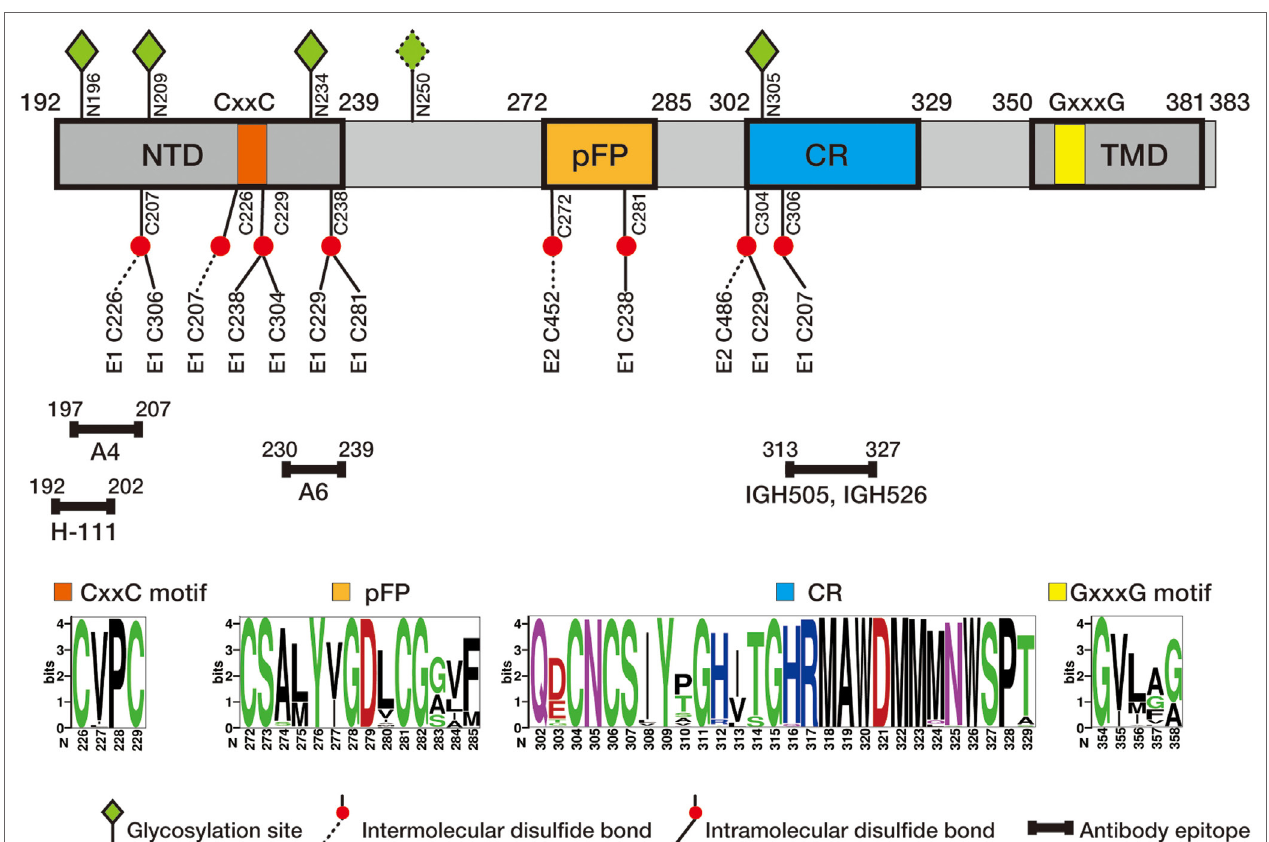
FiGURe 1 | Schematic diagram of hepatitis C virus (HCV) E1 envelope protein. E1 contains N-terminal domain (NTD, 192–239), putative fusion peptide (pFP, 272–285), conserved region (CR, 302–329), and C-terminal transmembrane domain (TMD, 350–381). CxxC motif in NTD and GxxxG motif in TMD are marked in orange and yellow, respectively. Four N-glycosylation sites (N196, N209, N234, and N305) conserved in all genotypes and one genotype 1b/6-specific site (N250) are labeled in green diamond, and conserved cysteine residues are labeled in red ball (intra- and intermolecular disulfide bounds in solid and dash line, respectively). Antibody epitopes, recognized by antibodies H-111 (9), A4 (10), A6 (11), IGH505, and IGH526 (12, 13), are marked with line segments. Of them H-111, IGH505, and IGH526 have been shown to neutralizing viral infection. The numbers correspond to the position of amino acid residues in the HCV polyprotein, with the first residue of E1 starting at 192. Sequence logos were generated based on 184 E1 sequences of genotype 1–6 from the Los Alamos hepatitis C sequence database (14) using WebLogo